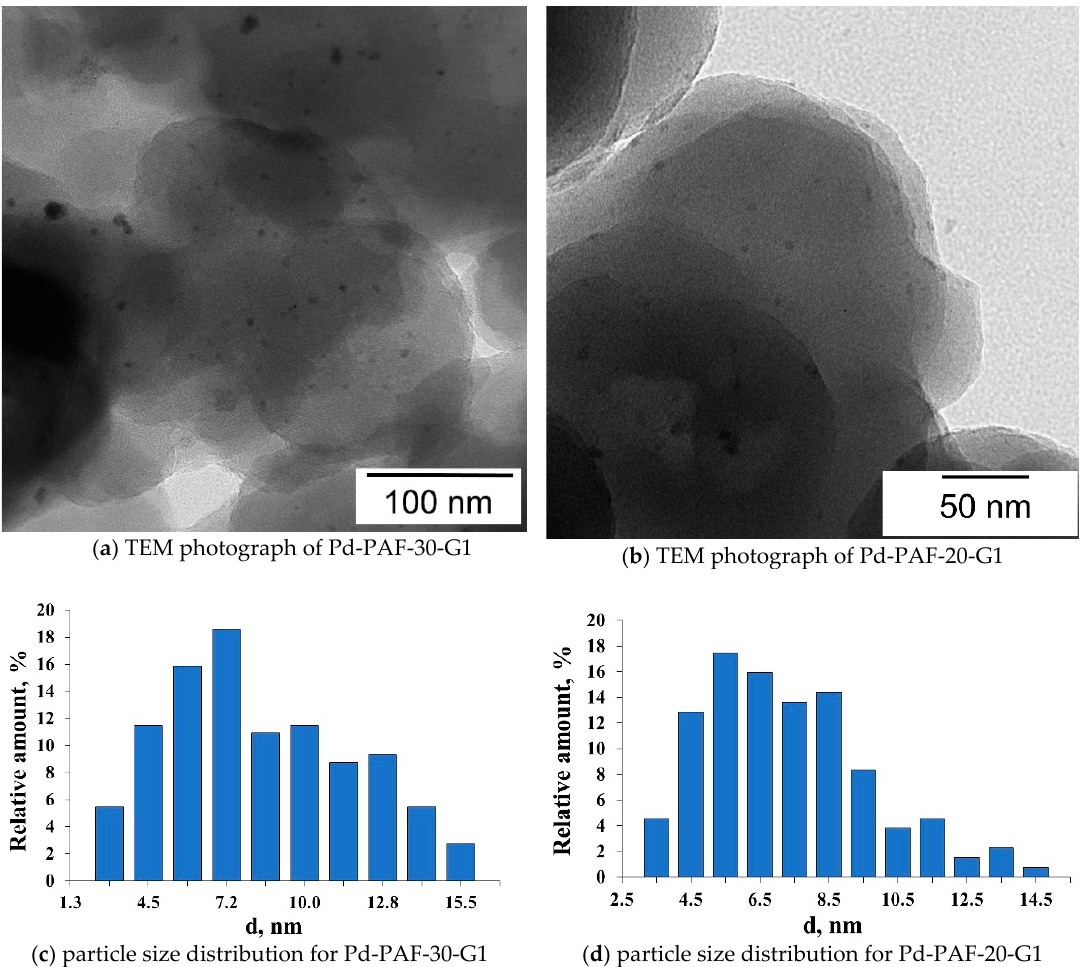
Figure 4. TEM microphotographs and particle size distribution for Pd–PAF-20-G1 and Pd-PAF-30-G1.